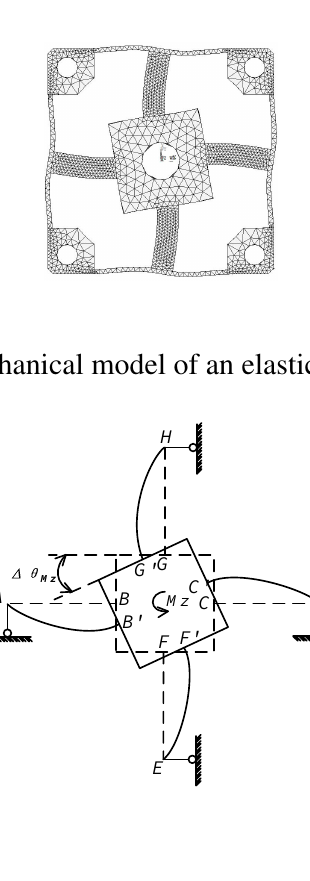
Figure 10. Deformation of an elastic body under M